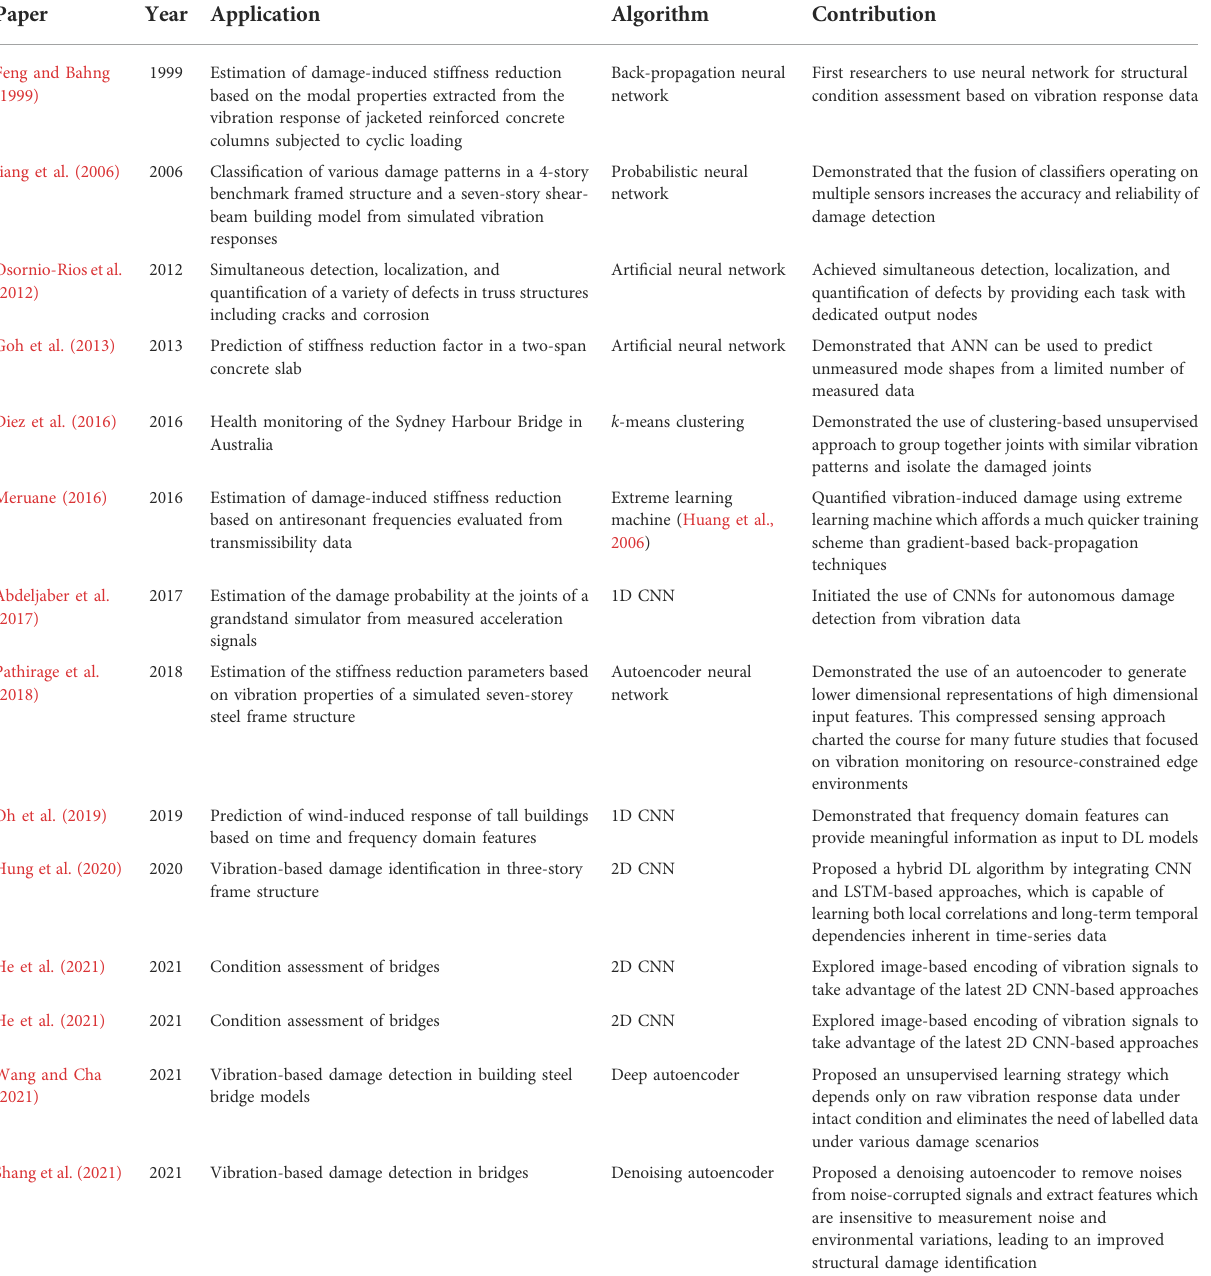
TABLE 4 Milestone papers focused on AI techniques for vibration-based